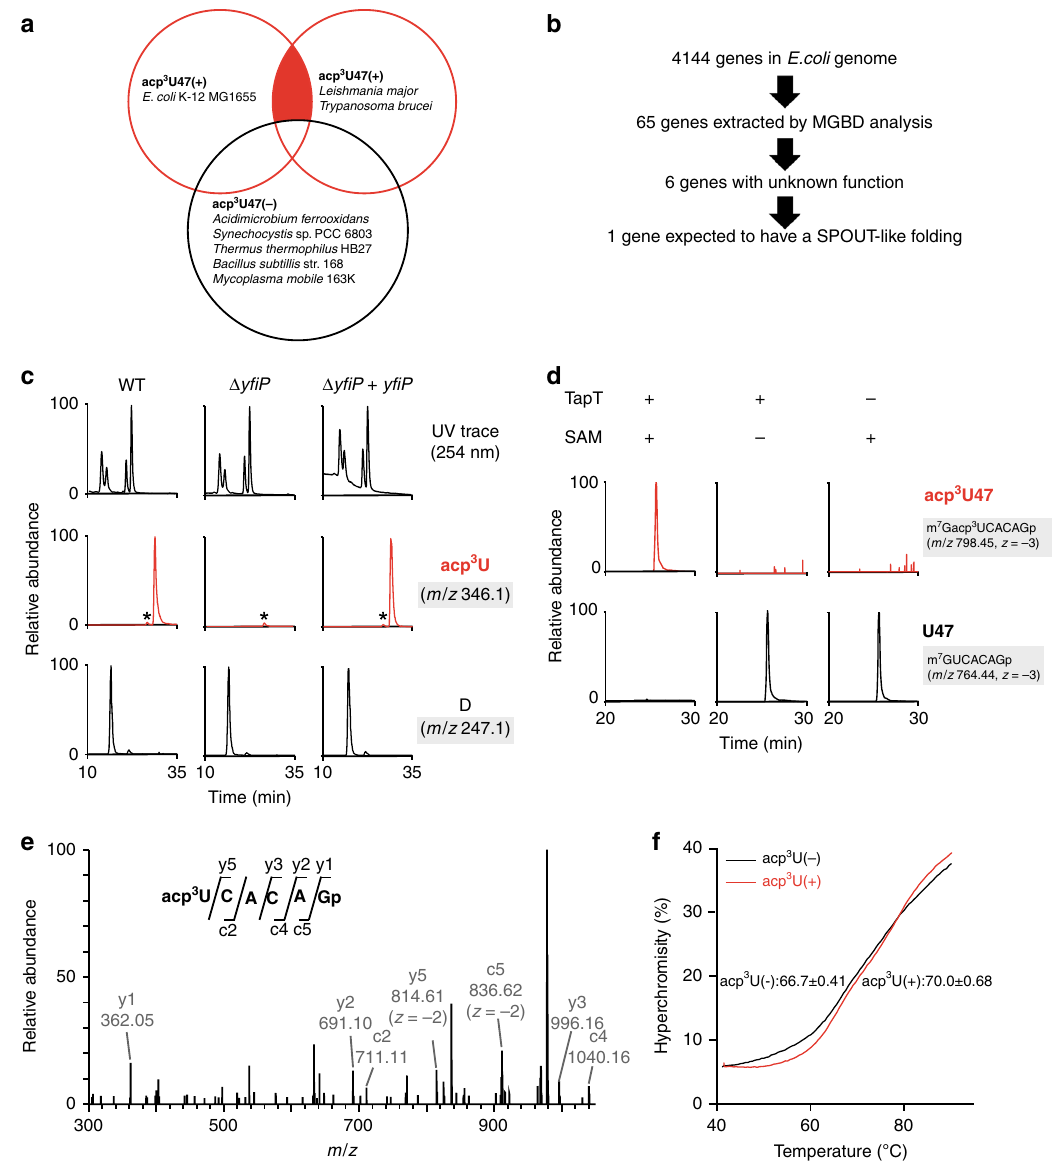
Fig. 2 y fi P is responsible for acp 3 U47 formation in E. coli . a Venn diagram to narrow down the candidates by comparative genomics. Each circle represents the gene sets that are commonly present in the organisms with ( + ) or without ( − ) acp 3 U. Red circles represent groups of organisms that have acp 3 U47, whereas the black circle represents organisms that do not have acp 3 U47. Candidate genes lie in the red- fi lled region. b The process of narrowing down the candidate genes responsible for acp 3 U47 formation by comparative genomics. c Mass spectrometric nucleoside analyses of tRNA modi fi cations from E. coli WT (left panels), Δ y fi P (center panels), an Δ y fi P rescued by plasmid-encoded y fi P (right panels). UV chromatogram (top) and extracted ion chromatograms (XICs) of the proton adducts of nucleosides for acp 3 U (middle) and D (bottom). Asterisks indicate nonspeci fi c peaks with the same m/z value. d In vitro reconstitution of acp 3 U47 in E. coli tRNA Met by recombinant TapT in the presence or absence of SAM. XICs show the indicated negative ions of the RNase T 1 -digested fragments with (top) or without (bottom) acp 3 U47. e Collision-induced dissociation spectrum of the acp 3 U-containing fragment of the tRNA Met transcript, in which acp 3 U was reconstituted in vitro. The precursor ion is m/z 678.43. The product ions were assigned on the corresponding sequence as described 93 . The data con fi rmed the presence of acp 3 U at position 47. f Melting curves of the in vitro transcribed tRNA Met with (red lines) or without (black lines) acp 3 U47 modi fi cation. T m values were determined based on the in fl ection point of the melting curve. Data represent average values of triplicates, with s.d. P < 4.1 × 10 − 3 by Student ’ s t test. Source data are provided as a Source Data fi